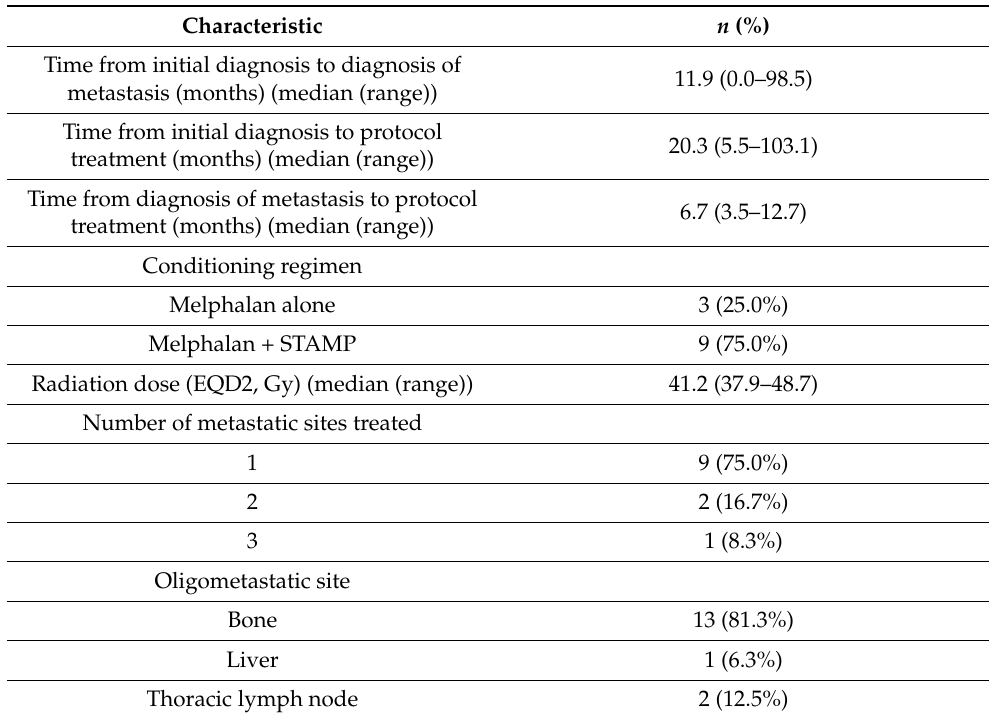
Table 1. Cont. Characteristic Time from initial diagnosis to diagnosis of